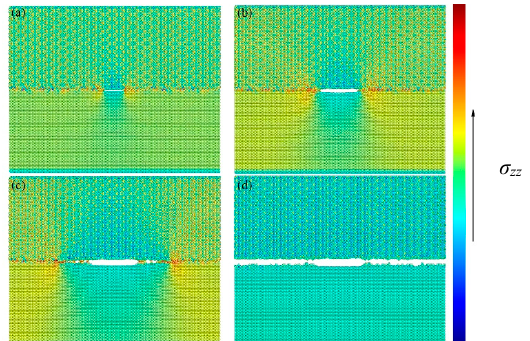
Figure 2. Atomistic configurations of the Mg/Mg 17 Al 12 bimaterial corresponding to different strains: ( a ) ε = 0.031; ( b ) ε = 0.041; ( c ) ε = 0.046; ( d ) ε = 0.055. Atoms are colored according to the zz component of the atomic stress.